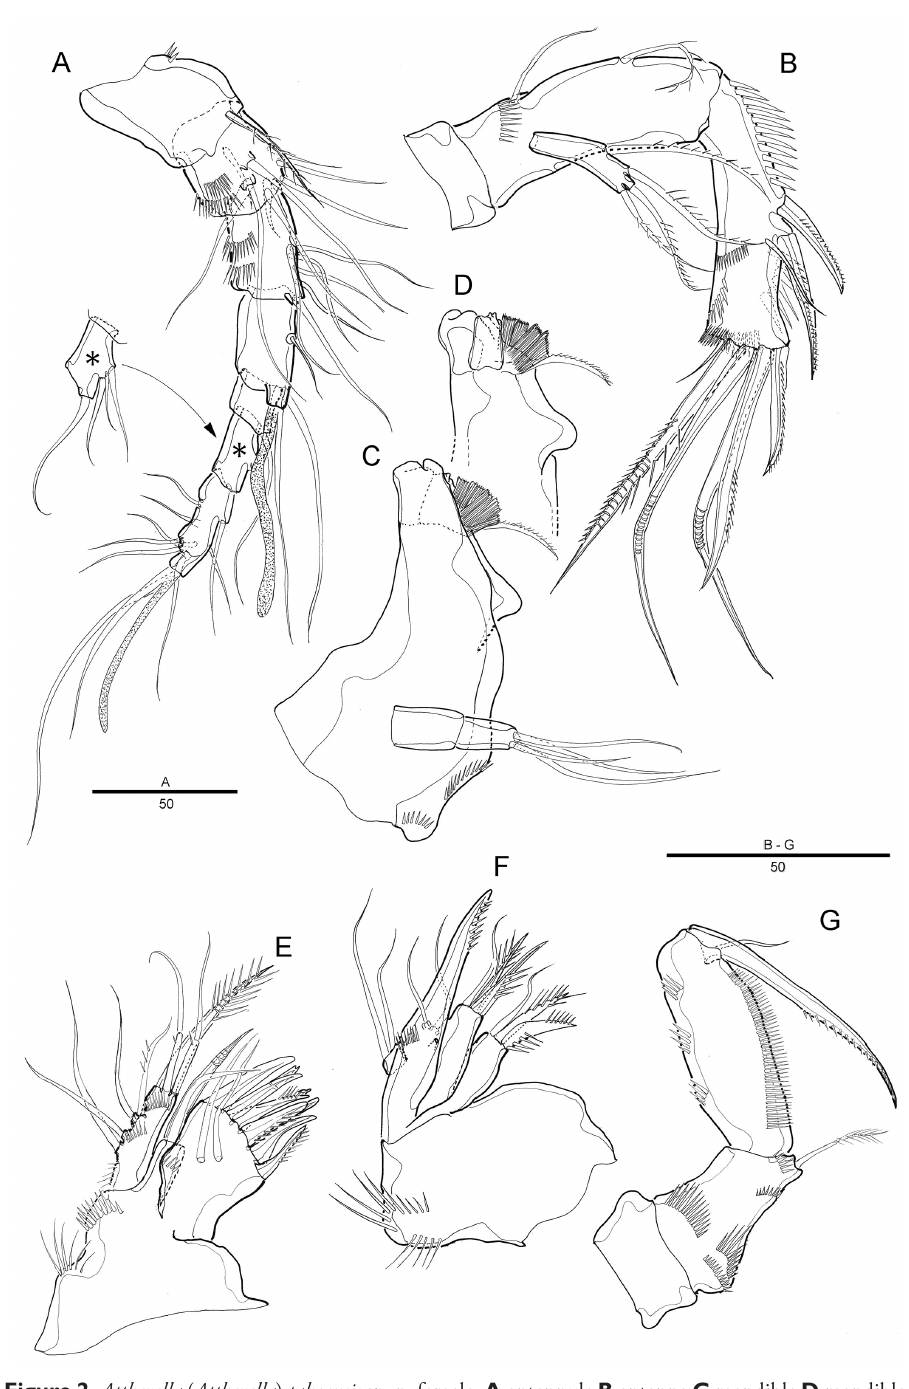
Figure 2. Attheyella ( Attheyella ) tahoensis sp. n. female: A antennule B antenna C mandible D mandible, other view E maxillule F maxilla G